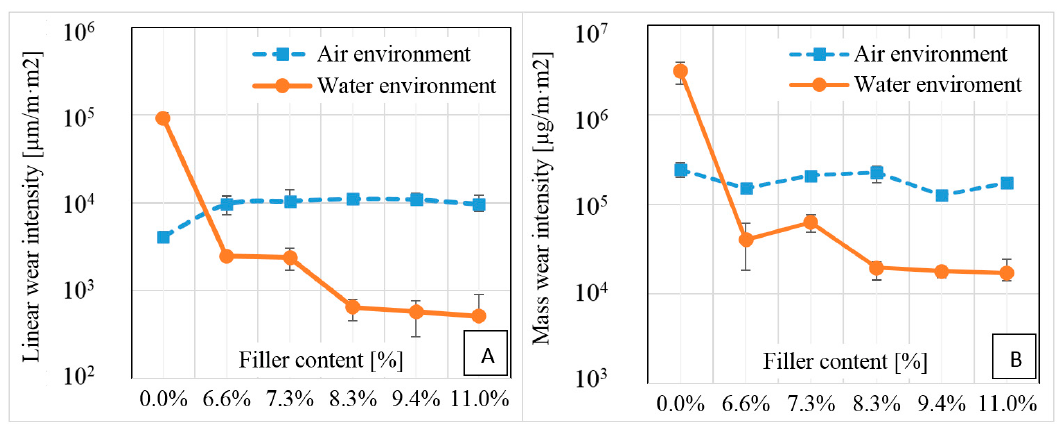
Figure 12. Influence of composite reinforcement on ( A ) intensity of linear wear, ( B ) intensity of mass wear in various environments of the system.